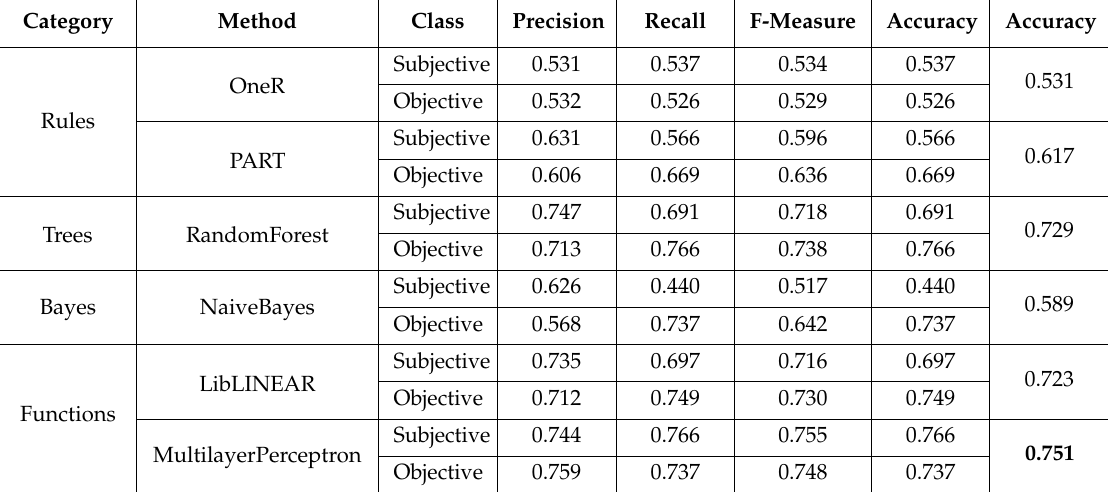
Table 7. Results for the centrality-based features.